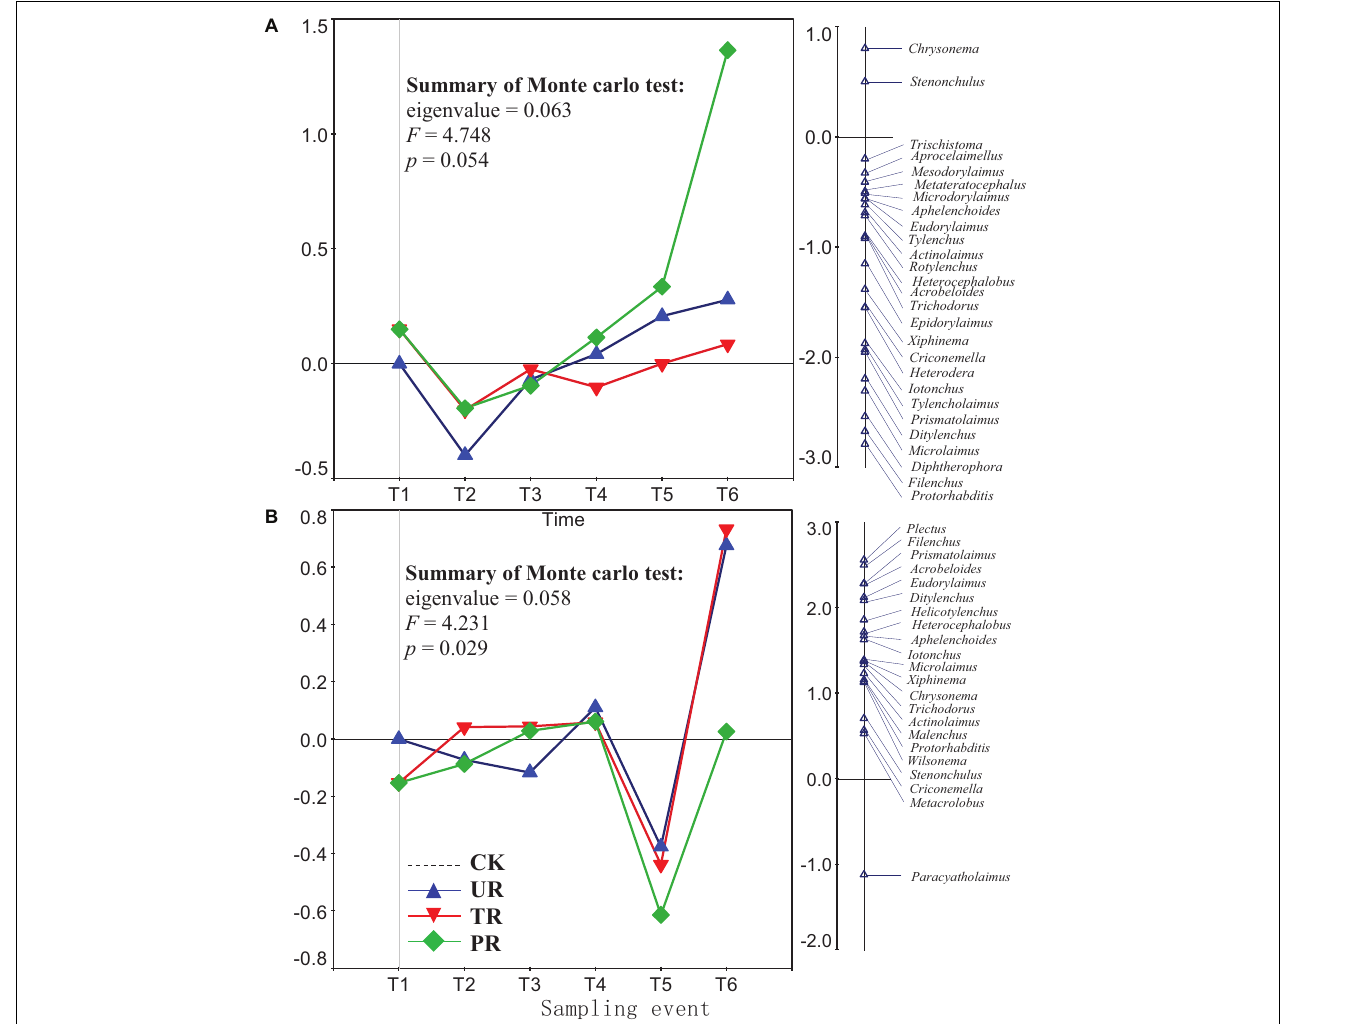
FIGURE 1 | Principal response curves (PRC) with weights of abundance of nematode genera in control (CK), understory removal (UR), tree removal (TR), and all-plant removal (PR) plots at (A) 0–5 cm and (B) 5–10 cm soil depths across six sampling events. The bi-plot on the left side representing temporal trajectories of nematode community for each of the treatments (CK, UR, TR, and PR). The vertical graph on the right side showing the nematode genus scores. The horizontal dotted line represents the control treatment. At each sampling event, the greater the deviation of a response curve (treatment curve) from horizontal line, the greater the differences of nematode communities between the treatment and control. T1–T6 are 10 days before and 8, 37, 162, 258, and 379 days after vegetation removal treatments were applied, respectively. The nematode genera with scores close to 0 are not shown on the first RDA axis (the right side of the plot). The deviation of abundance of a nematode genus from the control at a sampling time can be calculated with the equation: exp(value in curve × value of genus score on the first RDA axis). Particularly, values > 1 indicate increase in the abundances of nematode genera relative to CK, and values < 1 indicate decreases in abundances of nematode genera relative to